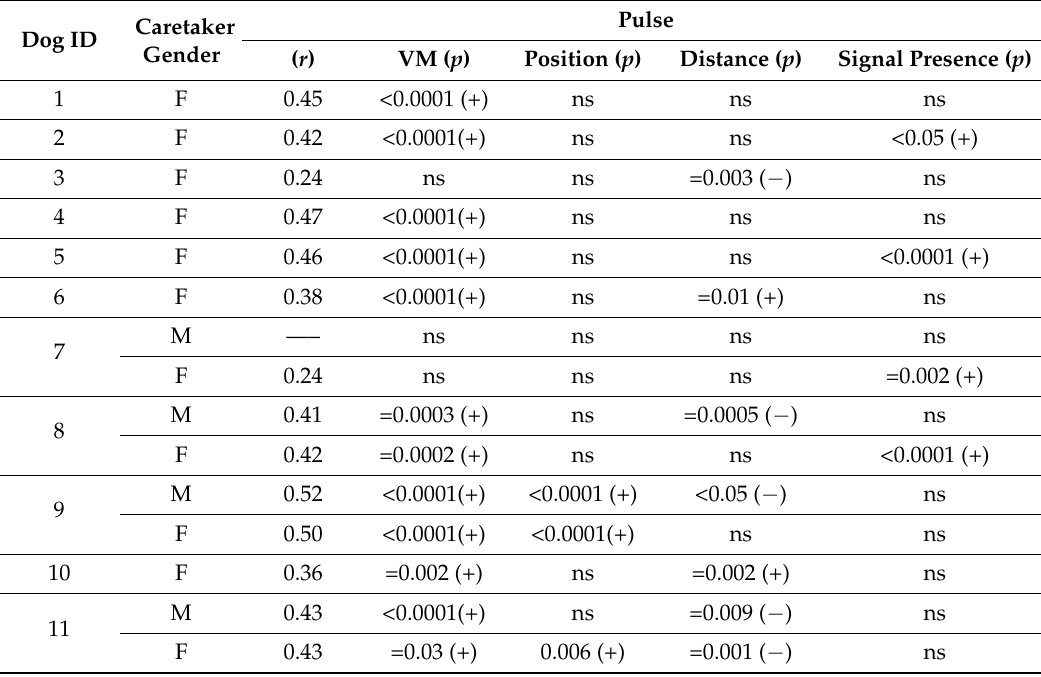
Table 4. Predictors of pulse during sedentary bouts.